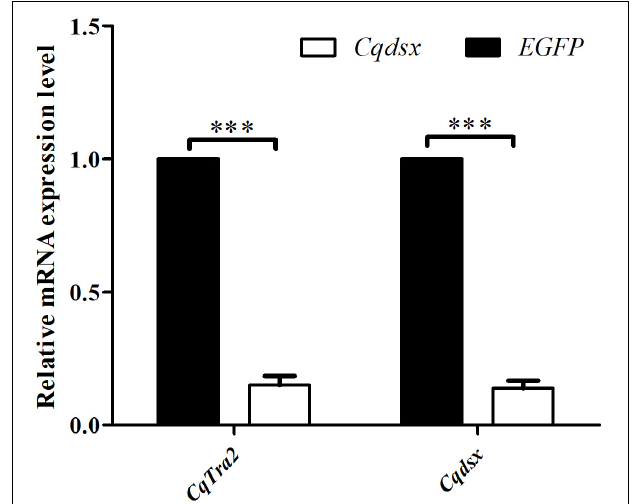
FIGURE 6 | Effects of CqTra2 -dsRNA injection on gene expression levels in cephalothoraxes of C. quadricarinatus. EGFP , treated with dsEGFP and used as RNAi control; CqTra2 , treated with dsCqTra. Three individuals were pooled as one sample. Three replicates were used for analysis. Results are expressed as mean ± SEM, and significance of comparison is defined as P < 0.001 (***) by Student’s t